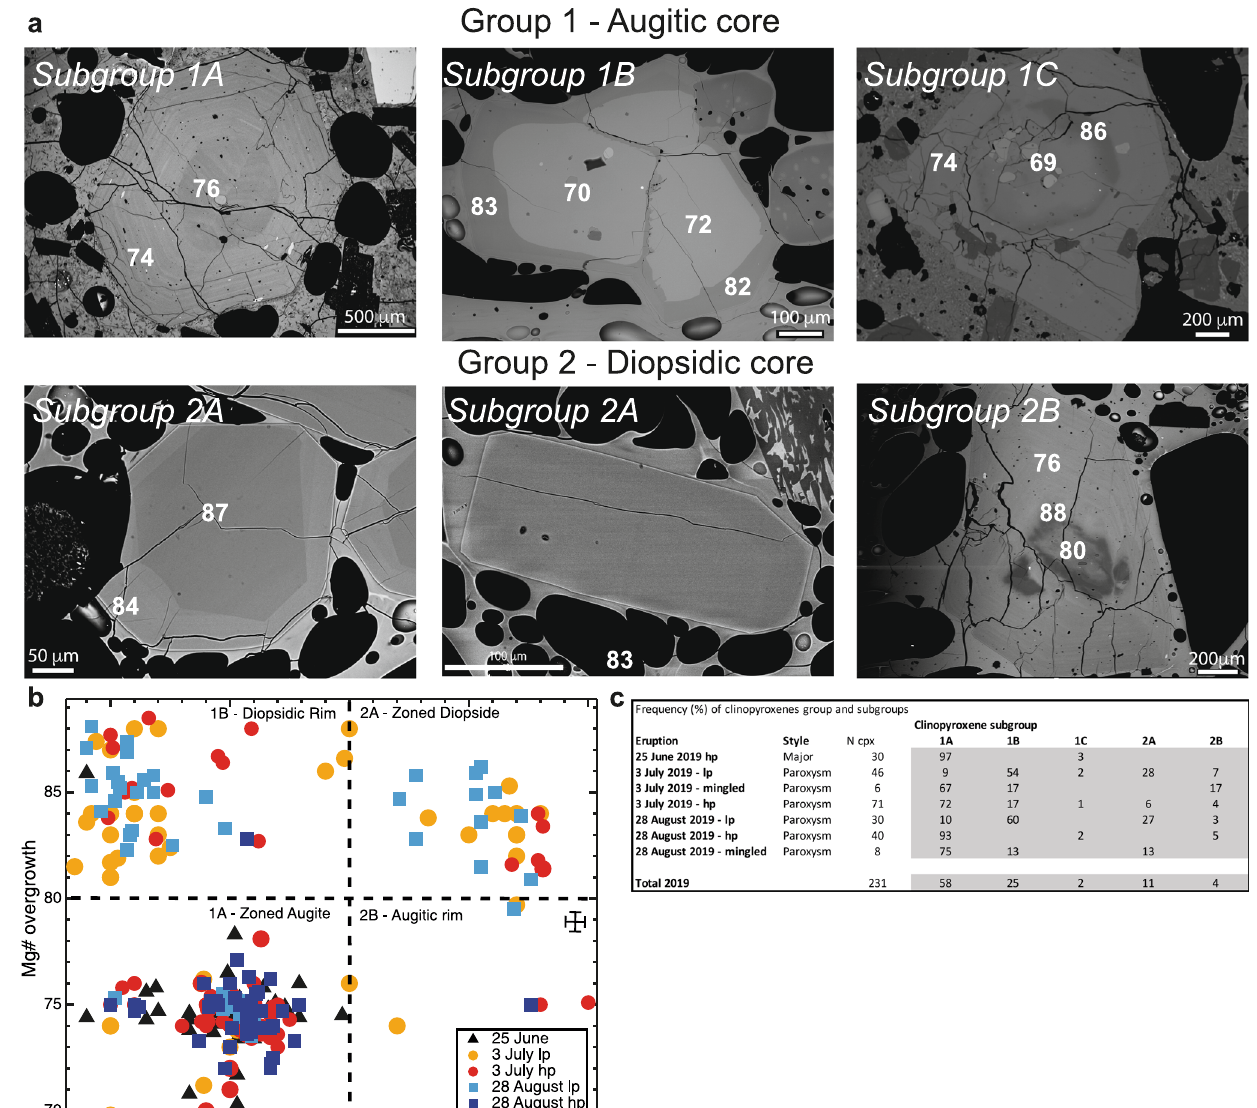
Fig. 2 | Textural classi fi cation, chemical composition, and frequency of 2019 clinopyroxenes. Clinopyroxenes from the major explosion of 25 June and the two paroxysms of 3 July and 28 August are euhedral with well-de fi ned edges and tabular forms, with both phenocrysts ( Lmax >0.3mm, on the basis of the longest size dimension) and microphenocrysts ( Lmax =0.3 – 0.1mm; cf. Mollo et al. 67 ) present ( a ) BSE(back-scatteredelectron)imagesforthe two groupsandrespectivesubgroupsof clinopyroxenes populations identi fi ed in the 25 June major explosions and the 3 July and 28 August paroxysms. The white numbers indicate the Mg# (Mg/(Mg+Fe 2+ tot ) at.) for the different portions of clinopyroxene and correspond to augitic (Mg# 69 – 79 ) and diopsidic (Mg# 80 – 90 ) compositions. Subgroup 1A (zoned augite): Px3 sample P30-09- 2-hp, 3 July paroxysm; subgroup 1B (diopsidic overgrowth): Px4-5 sample P24-3-lp, 3Julyparoxysm;subgroup1C(diopsidicband):Px35sample25062019,25Junemajor